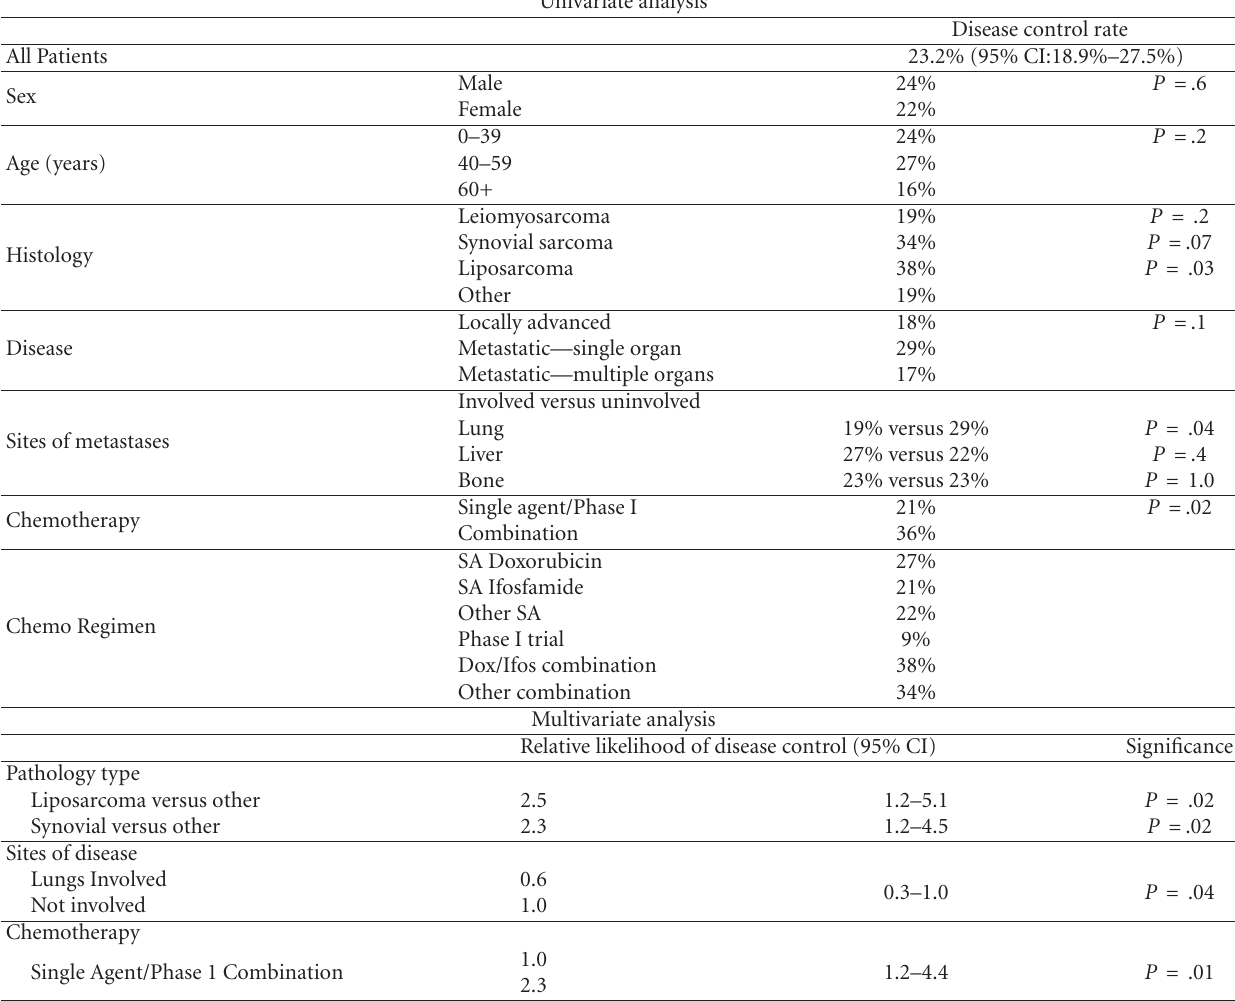
Table 4: Univariate and multivariate analysis of disease control rate. Univariate analysis